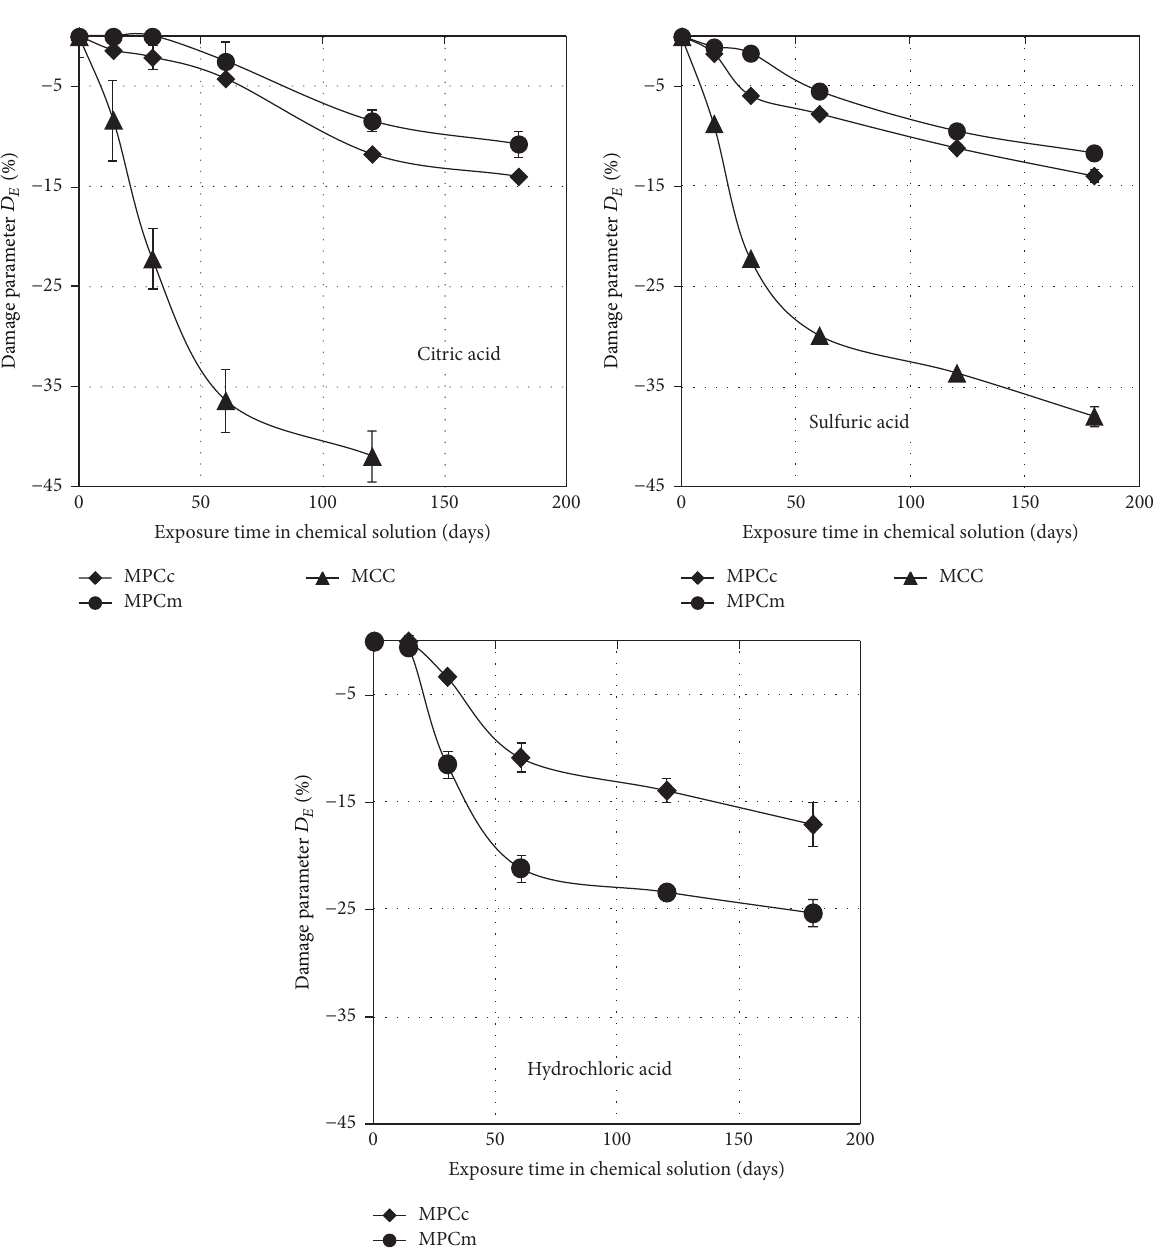
Figure 6: Evolution of modulus of elasticity as a function of exposure